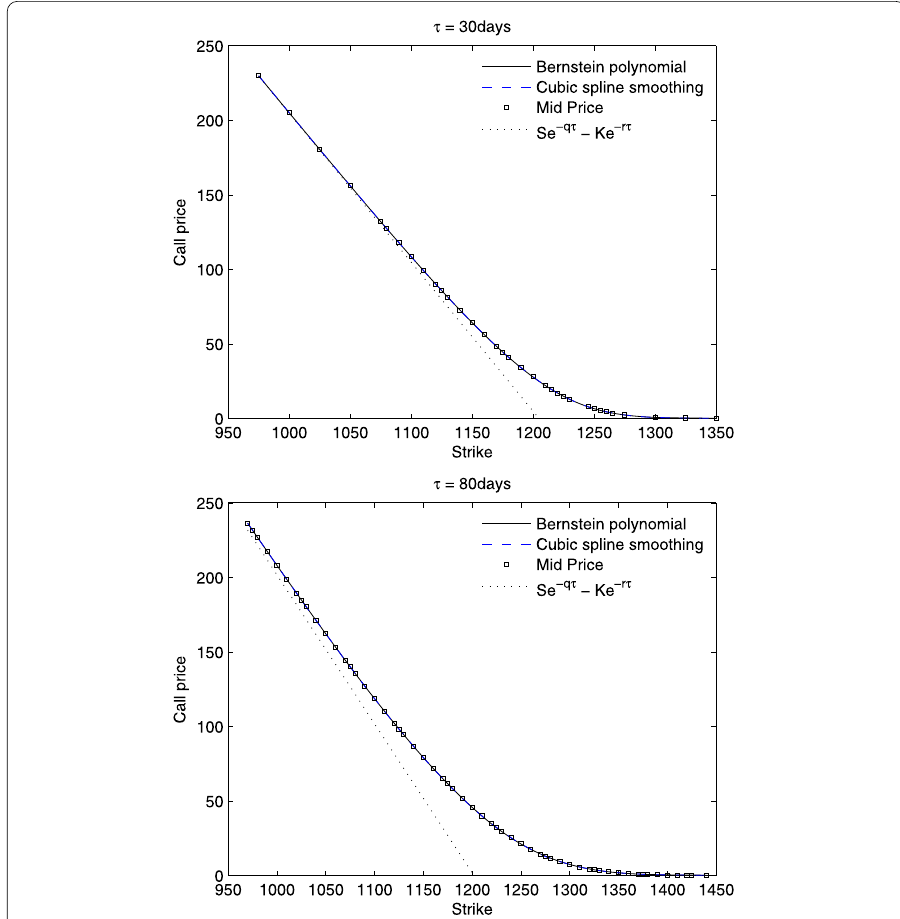
Figure 1 Estimated call price functions for both of the times to maturity of τ = 30 days and τ = 80 days,